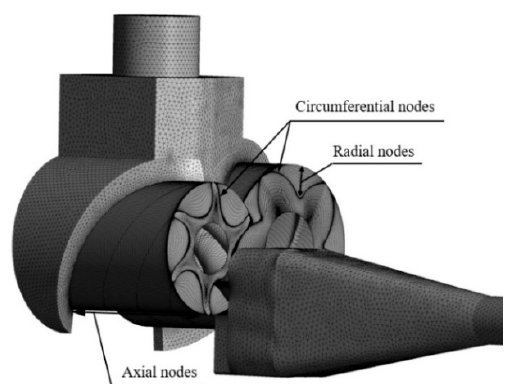
Figure 3. The control volume cells of the experimental compressor.